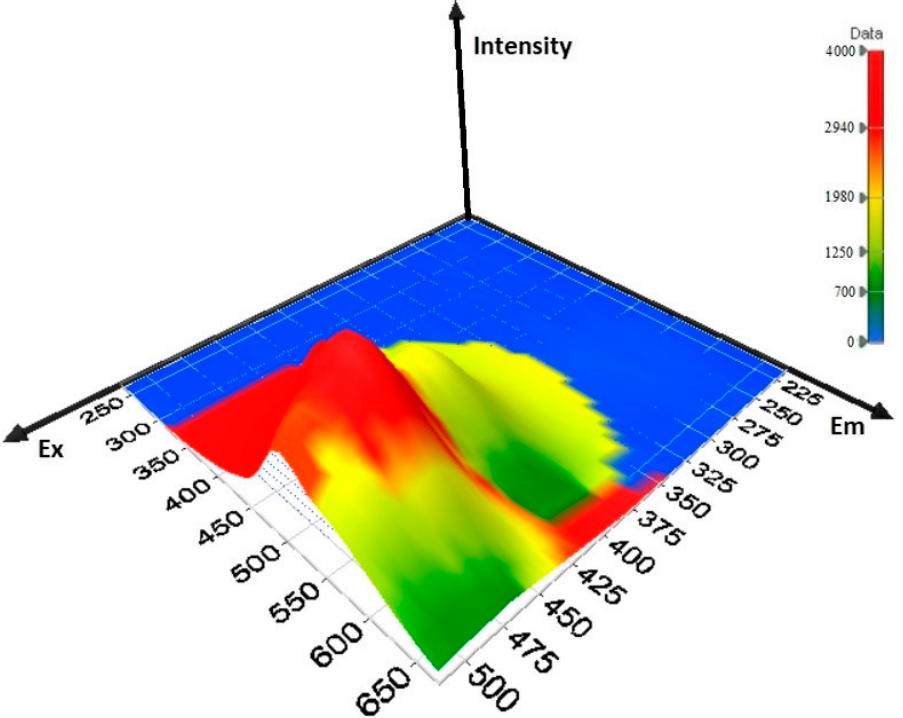
Figure 3. Characteristic 3D-EEM spectra of fir honey.